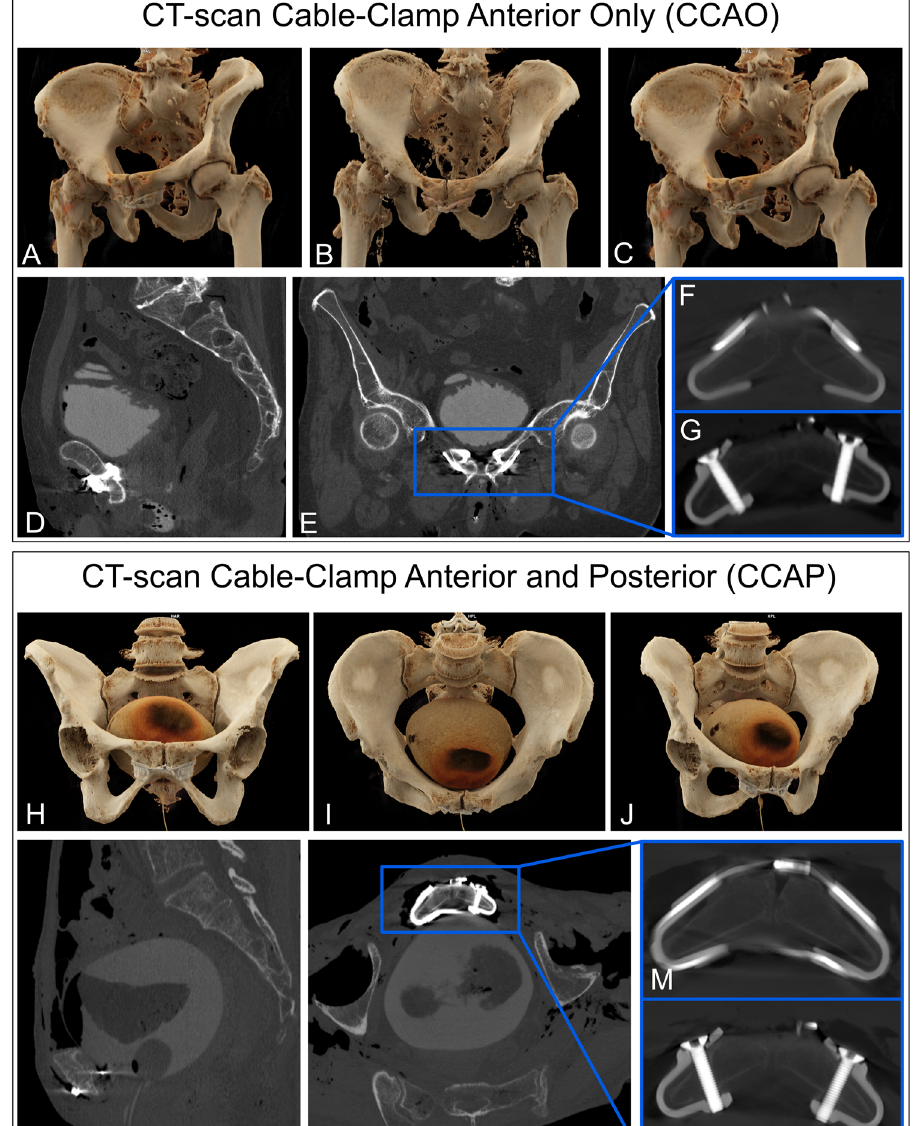
Fig. 10 Implant evaluation by computed tomography. Top: ( A – C ) CT images of the CCAO device implanted at the pubic symphysis. D , E Sagittal and axial CT images of the intact bladder fi lled with contrast fl uid. F , G Enlarged images showing the good implant fi t to the bone, anterior placement of the cable, and screws fi xing the clamp to the bone. Bottom: ( H – J ) CT images of the CCAP and contrast- fi lled bladder. K , L Sagittal and axial CT images of the contrast- fi lled bladder containing a frozen blood clot. M , N Enlarged images showing the implant fi t to the bone, cable surrounding the pubic symphysis, and screws fi xing the clamp to the